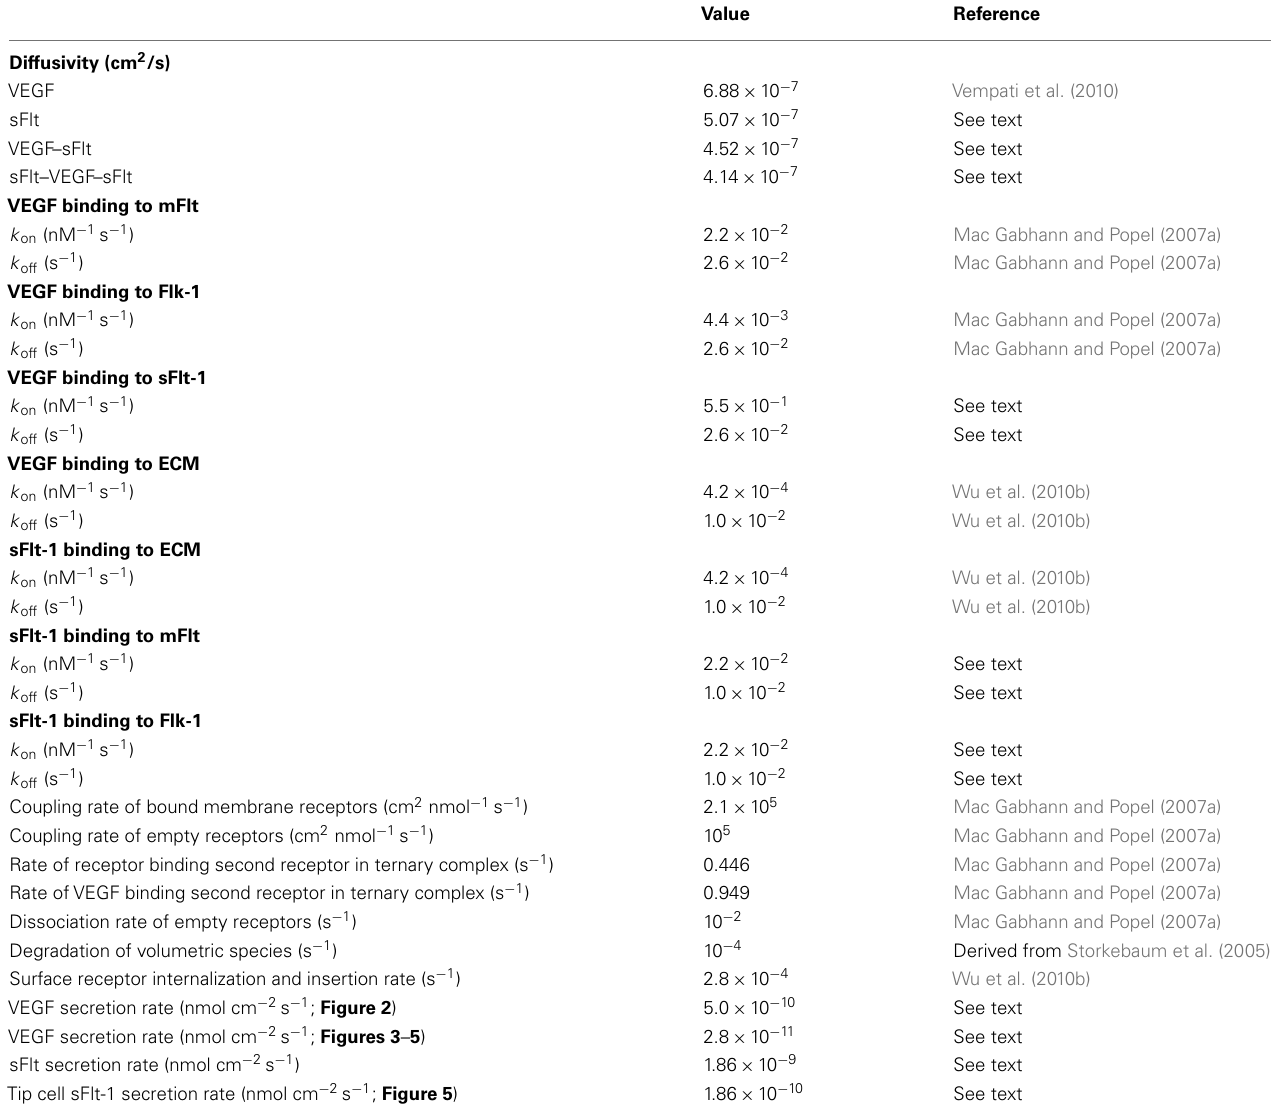
Table 1 | Kinetic parameters of theVEGF